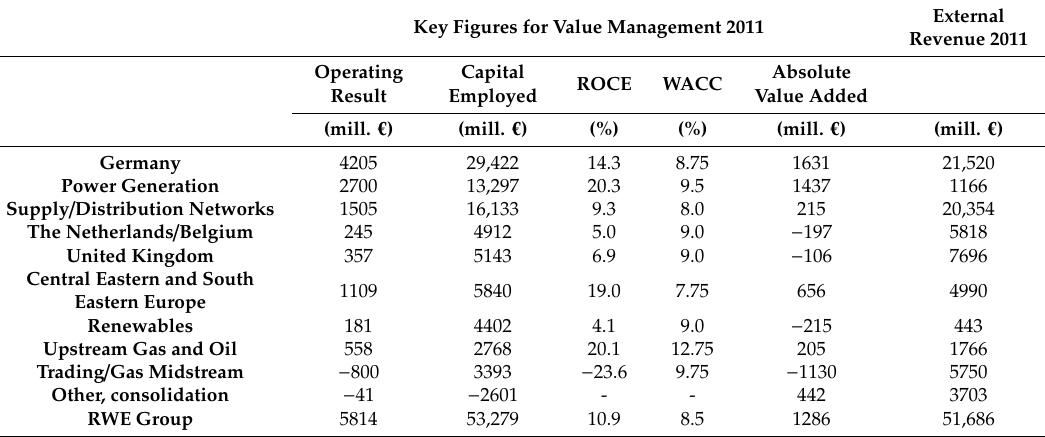
Table 4. RWE’s 2011 key figures for value management and external